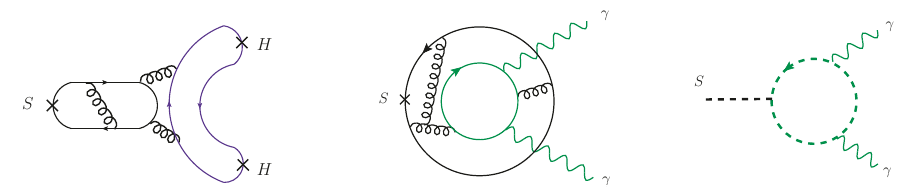
2 and S 2 couplings (left) and SF (cid:22)(cid:23) H D (cid:22) H (cid:22)(cid:23) F j j j j